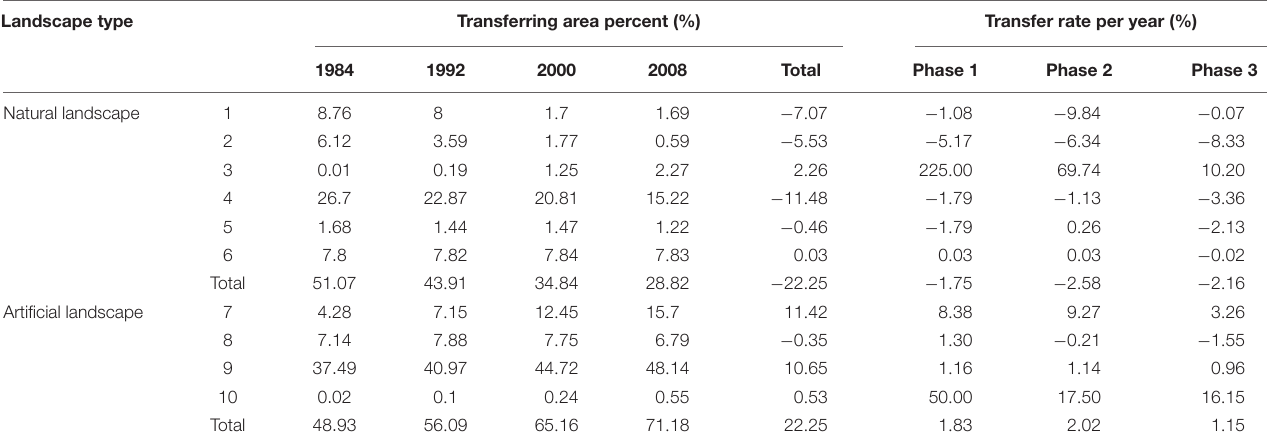
TABLE 2 | Dynamic transfer rate of land-use in Yancheng coast. Landscape type